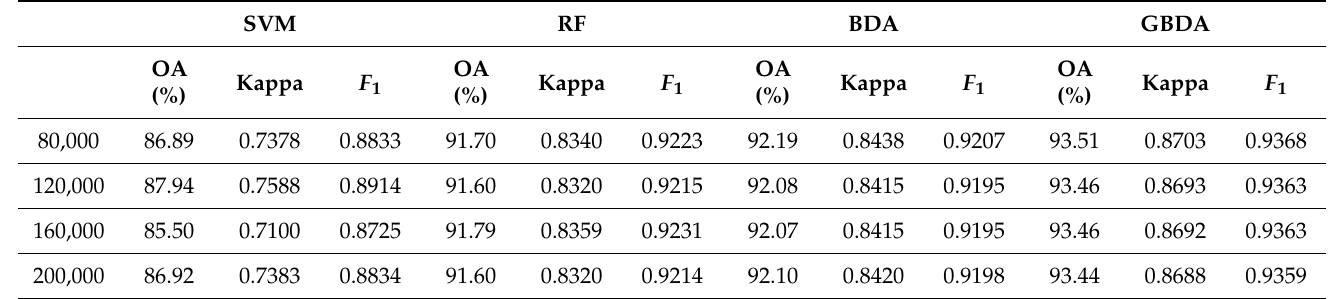
Figure 12. Results of impervious surface extraction with GBDA: ( a ) 80,000 samples; ( b ) 120,000 samples; ( c ) 160,000 samples; ( d ) 200,000 samples. Table 2. Accuracy assessment of impervious surface of Sentinel-2 remote sensing